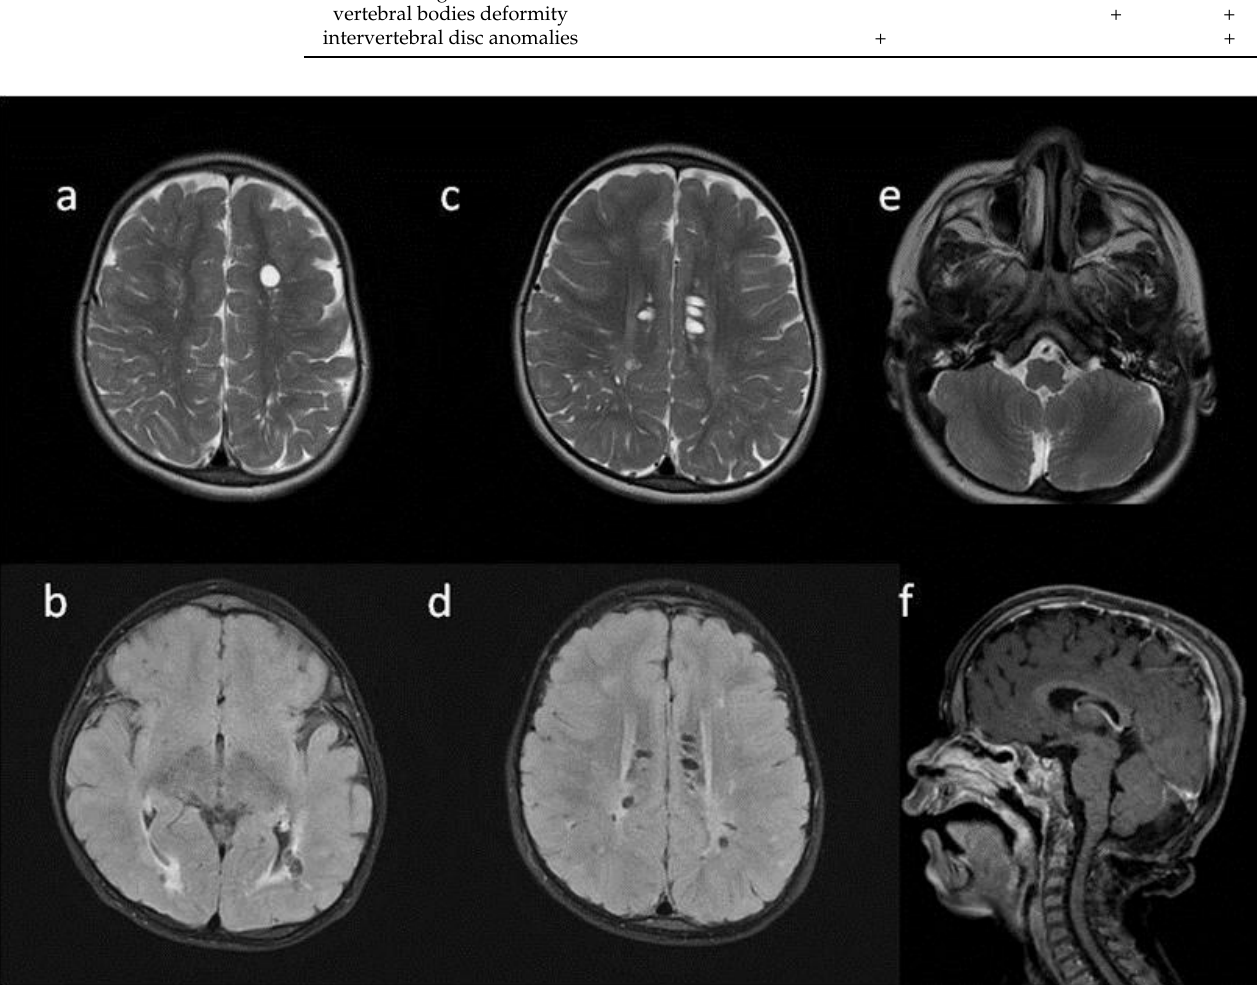
Figure 2. Brain MRI. Patient 2. ( a , c , e ) axial T2; ( b , d ) axial T2 FLAIR ; ( f ) sagittal T1. Findings: ( a , c , d ) enlarged PVS with characteristic location in corpus callosum; ( a – d ) abnormal white matter signals; ( e ) posterior fossa horns; ( f ) J-shaped sella turcica, dysplastic dens.